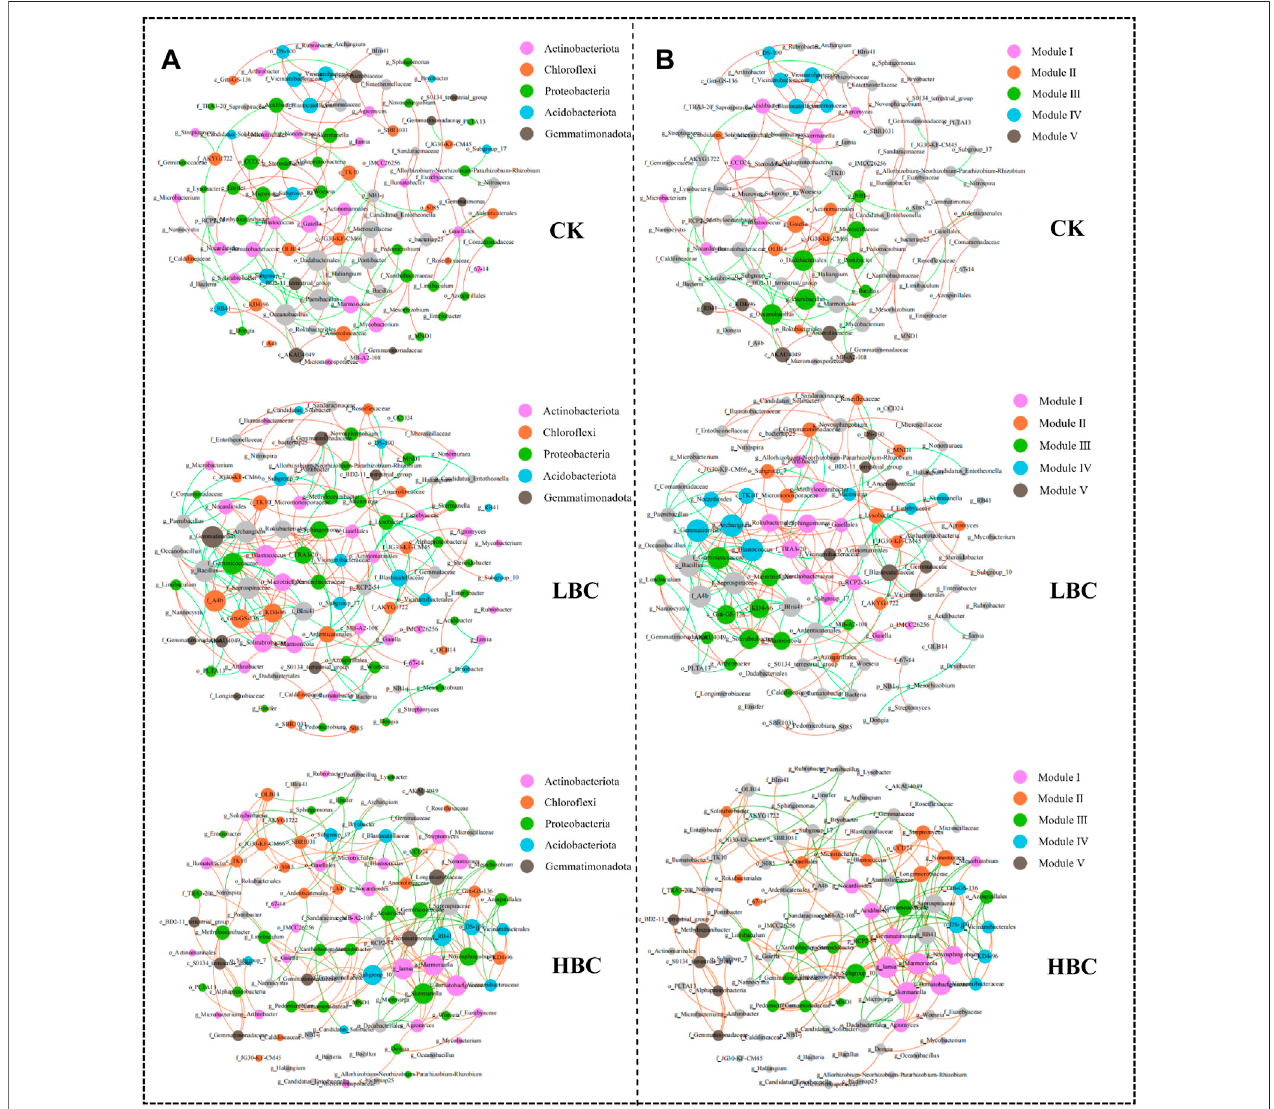
FIGURE 4 | The bacterial co-occurrence networks (at the genus level) based on correlation analysis under the non-amended and biochar-amended treatments. The visualized connections reveal strong (Spearman ’ s p > 0.9) and signi fi cant ( p value < 0.01) correlations. Bacterial networks are colored by phyla (A) and modules (B) , respectively. The modules I – V in the networks stand for the fi ve clusters of closely interconnected nodes. The node size is proportional to the connection number (degree), and the connection thickness is proportional to Spearman ’ s correlation coef fi cient values. The red and green edges indicate positive and negative interactionsbetweentwonodes,respectively.Thekeystonetaxawereidenti fi edaccordingtothemodulehubs.CK,soilwithoutbiocharamendment;LBC,soilamended with a low amount of biochar at 18/t ha; HBC, soil amended with a high amount of biochar at 36 t/ha.